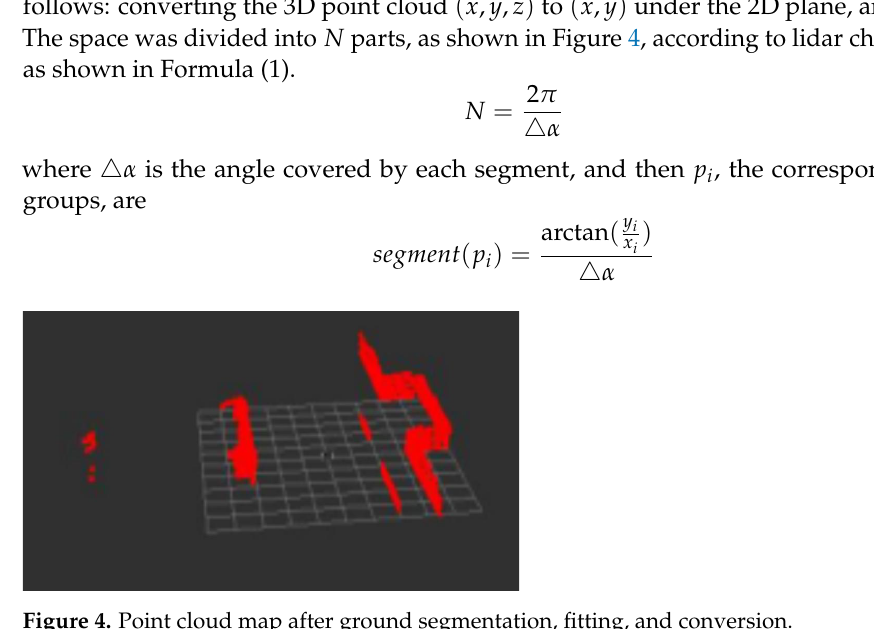
Figure 4. Point cloud map after ground segmentation, fitting, and